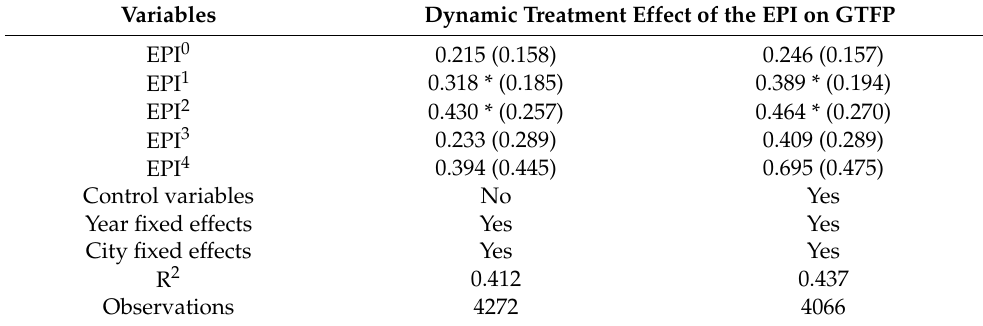
Table 3. Dynamic treatment effect of the EPI on